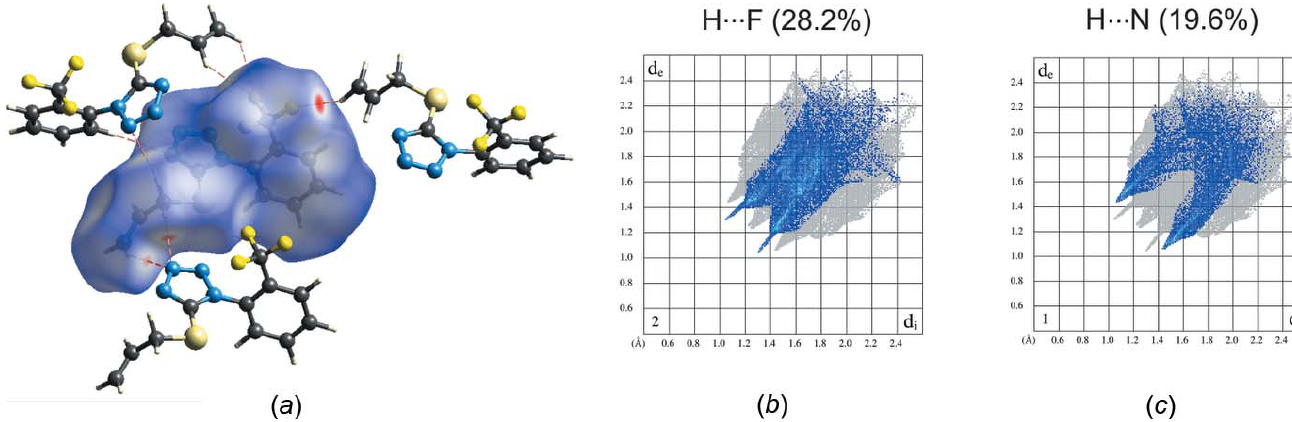
Figure 5 ( a ) Hirshfeld surface for molecule of (I) mapped with d norm over the range (cid:5) 0.15 to 1.2 showing C—H (cid:3)(cid:3)(cid:3) N and C—H (cid:3)(cid:3)(cid:3) F hydrogen-bonded contacts. Fingerprint plots for molecule resolved into ( b ) F (cid:3)(cid:3)(cid:3) H/H (cid:3)(cid:3)(cid:3) F and ( c ) N (cid:3)(cid:3)(cid:3) H/H (cid:3)(cid:3)(cid:3) N contacts. Neighbouring molecules associated with close contacts are also